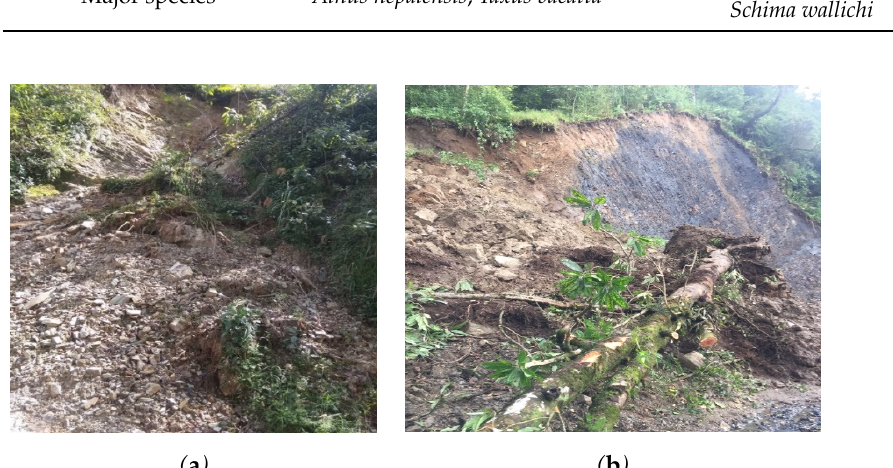
Figure 1. Location map of study area in the Sindhupalchok district.